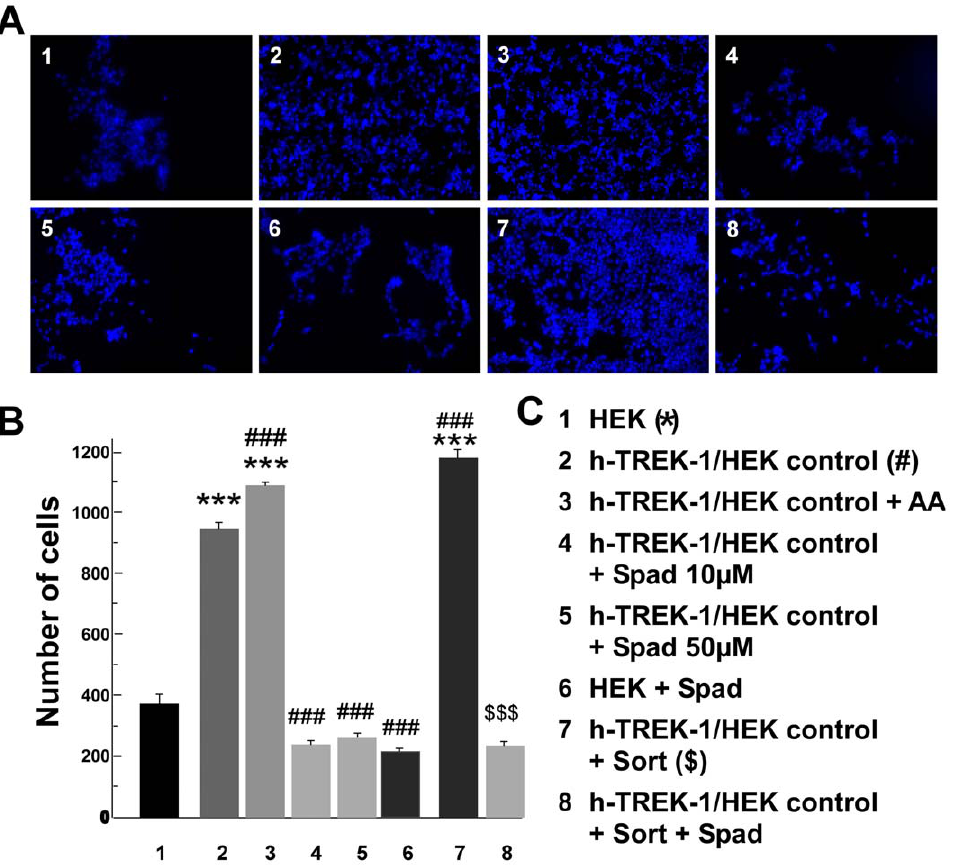
Figure 6. Oxygen deprivation glucose experiments (OGD) on h-TREK-1/HEK cells and on HEK cells (A, B). After two hours of OGD in control conditions or with different treatments, survival cells were fixed, labeled and counted (n=8 for each groups). A) Typical pictures of cells from each tested condition. B) Histograms of number of survival cells (Tukey test, F 7,568 =38.65; *** or ### or $$$ p , 0.001) c) The different tested conditions and their corresponding number.